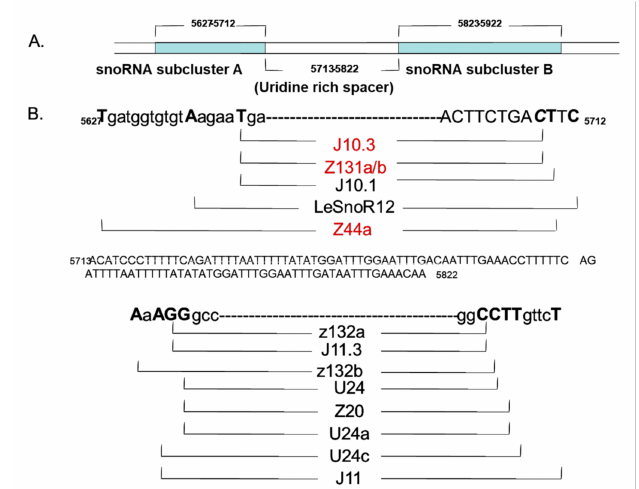
Figure 2. C / D box small nucleolar RNAs (snoRNAs) separated by a uridine rich spacer identified in tomato. Shown are snoRNA subcluster A ( A ) and snoRNA subcluster B ( B ) decorated with other C / D box snoRNAs, namely, J10.3, Z131a / b, J10.1, and Z44a followed by z132a, J11.3, z132b, U24, Z20, U24a, and J11. Several of these, for example, SlZ44a , Slz132b, and SlU24a , share conserved sequences with those in Arabidopsis and rice (Figure S2). For other details see